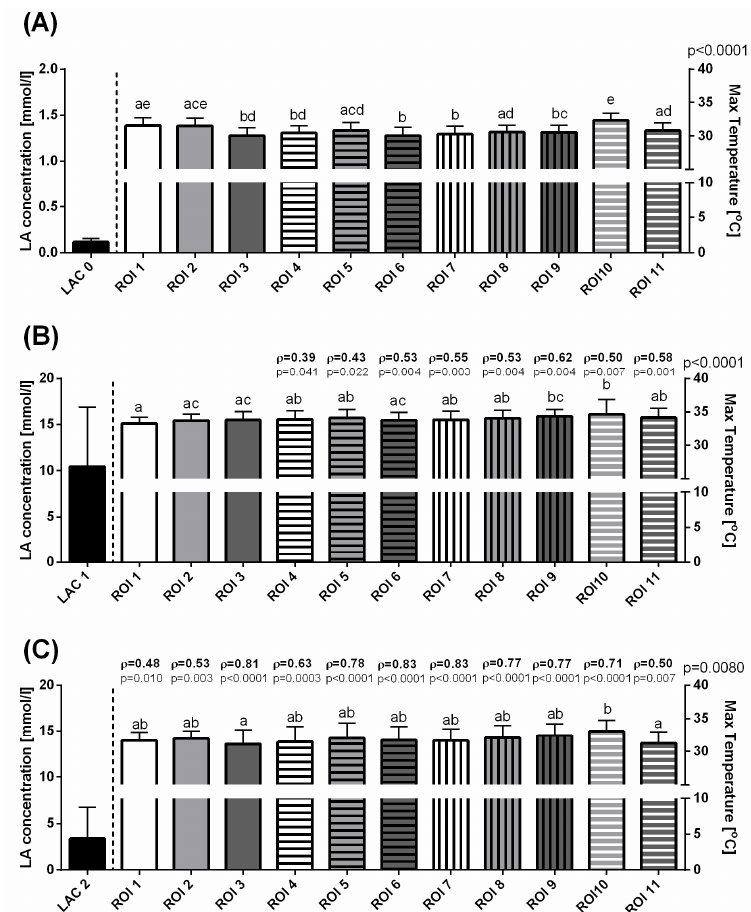
Figure 3. The blood lactate concentration and maximal temperatures (mean + SD) in the selected ROIs before training ( A ), immediately after exercise ( B ), and 30 minutes after exercise ( C ). Lowercase letters indicate differences between regions of interest (ROIs) for p < 0.05. The p -value for ROI comparison is indicated above the right X -axis. The correlations between blood lactate concentration and maximum temperatures are indicated above consecutive temperature bars using the Spearman correlation coefficient ( ρ ), which reflected the consistency when p < 0.05.